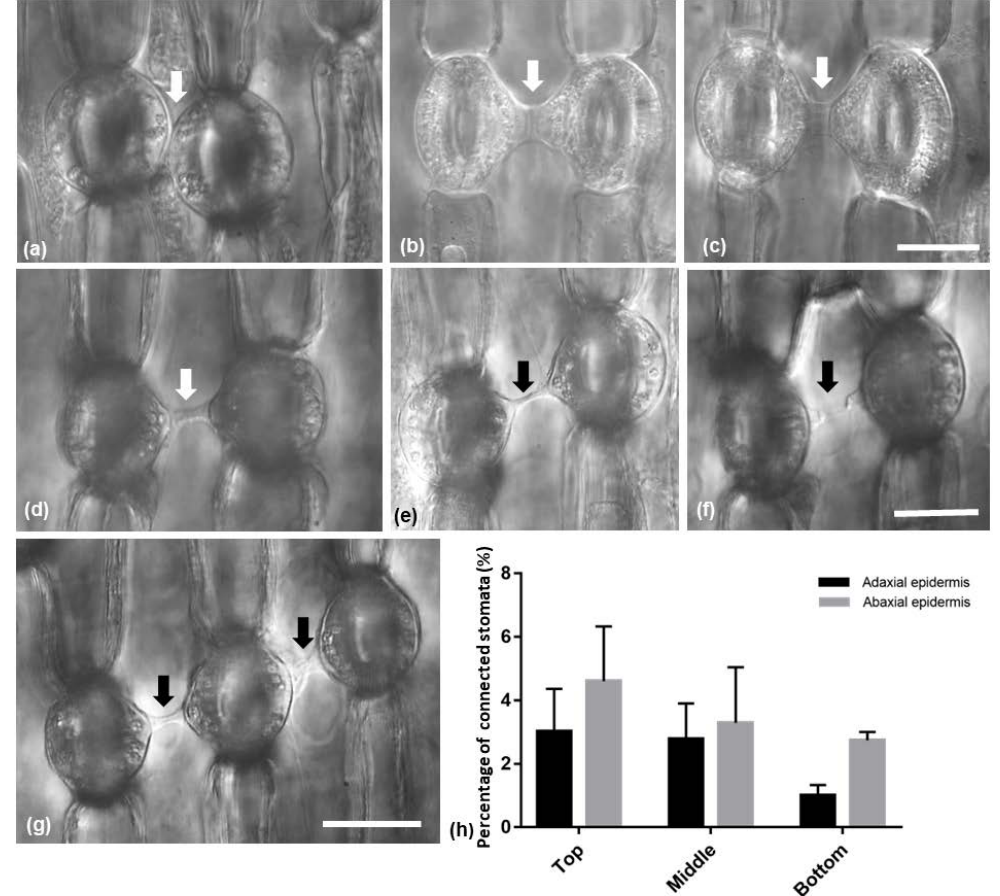
Figure 4. ( a – g ) Light micrographs of paradermal leaf sections with DIC (Nomarski) optics, showing (arrows) the morphological variety among the observed connecting strands of adjacent stomata. ( h ) Diagram showing the percentage of connected stomata on the adaxial and the abaxial epidermis. The values are means of ten different leaves of the same size; significant differences ( p < 0.05) were not found. Scale bars: 20 μm.